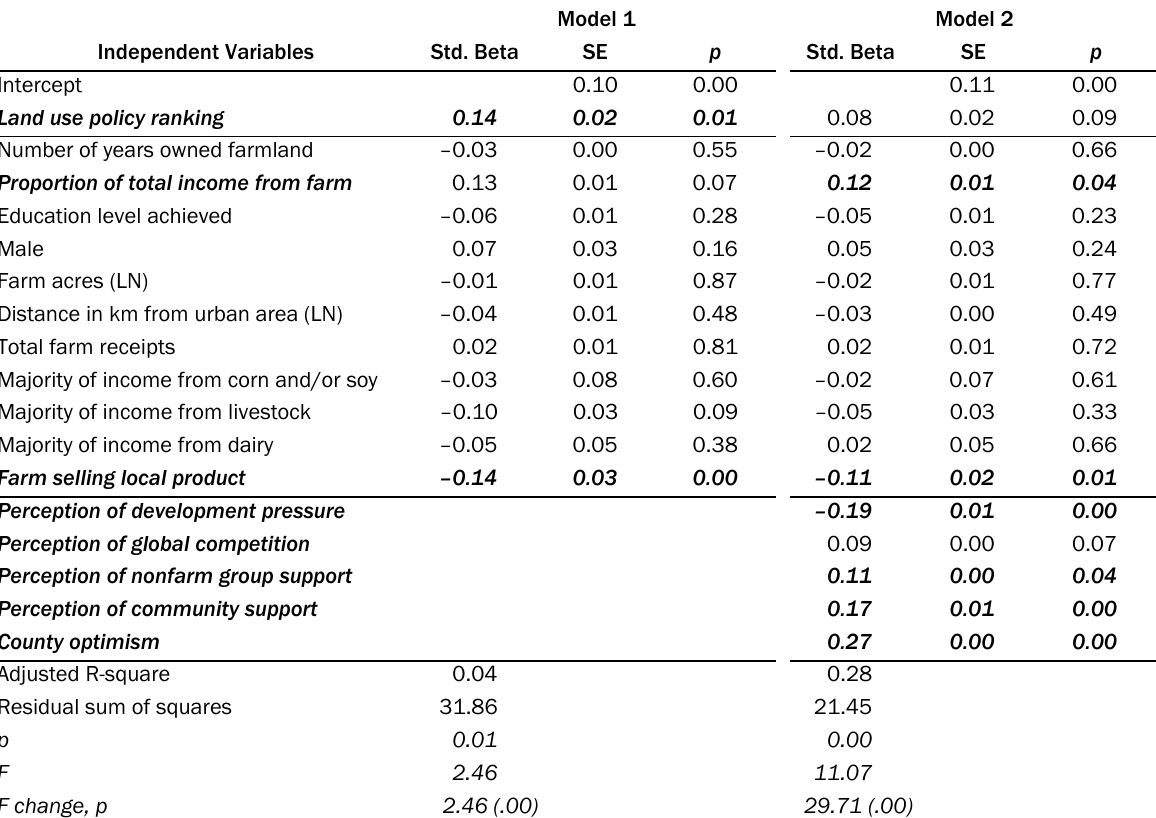
Table 5. Regression